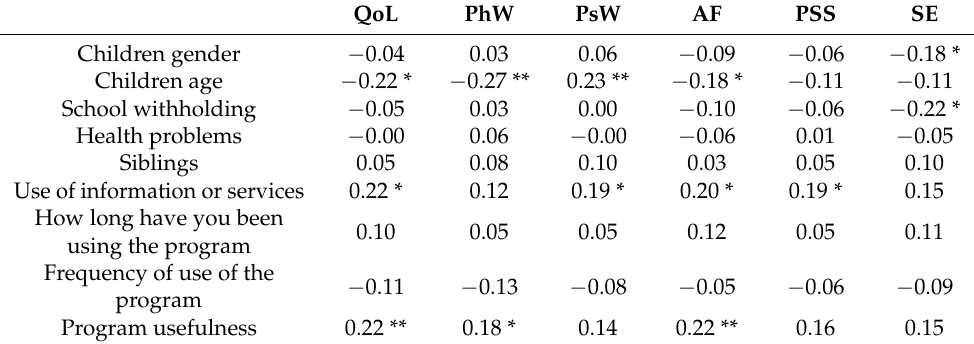
Table 6. Correlations between the children’ characteristics, JAF outcomes and QoL ( n =